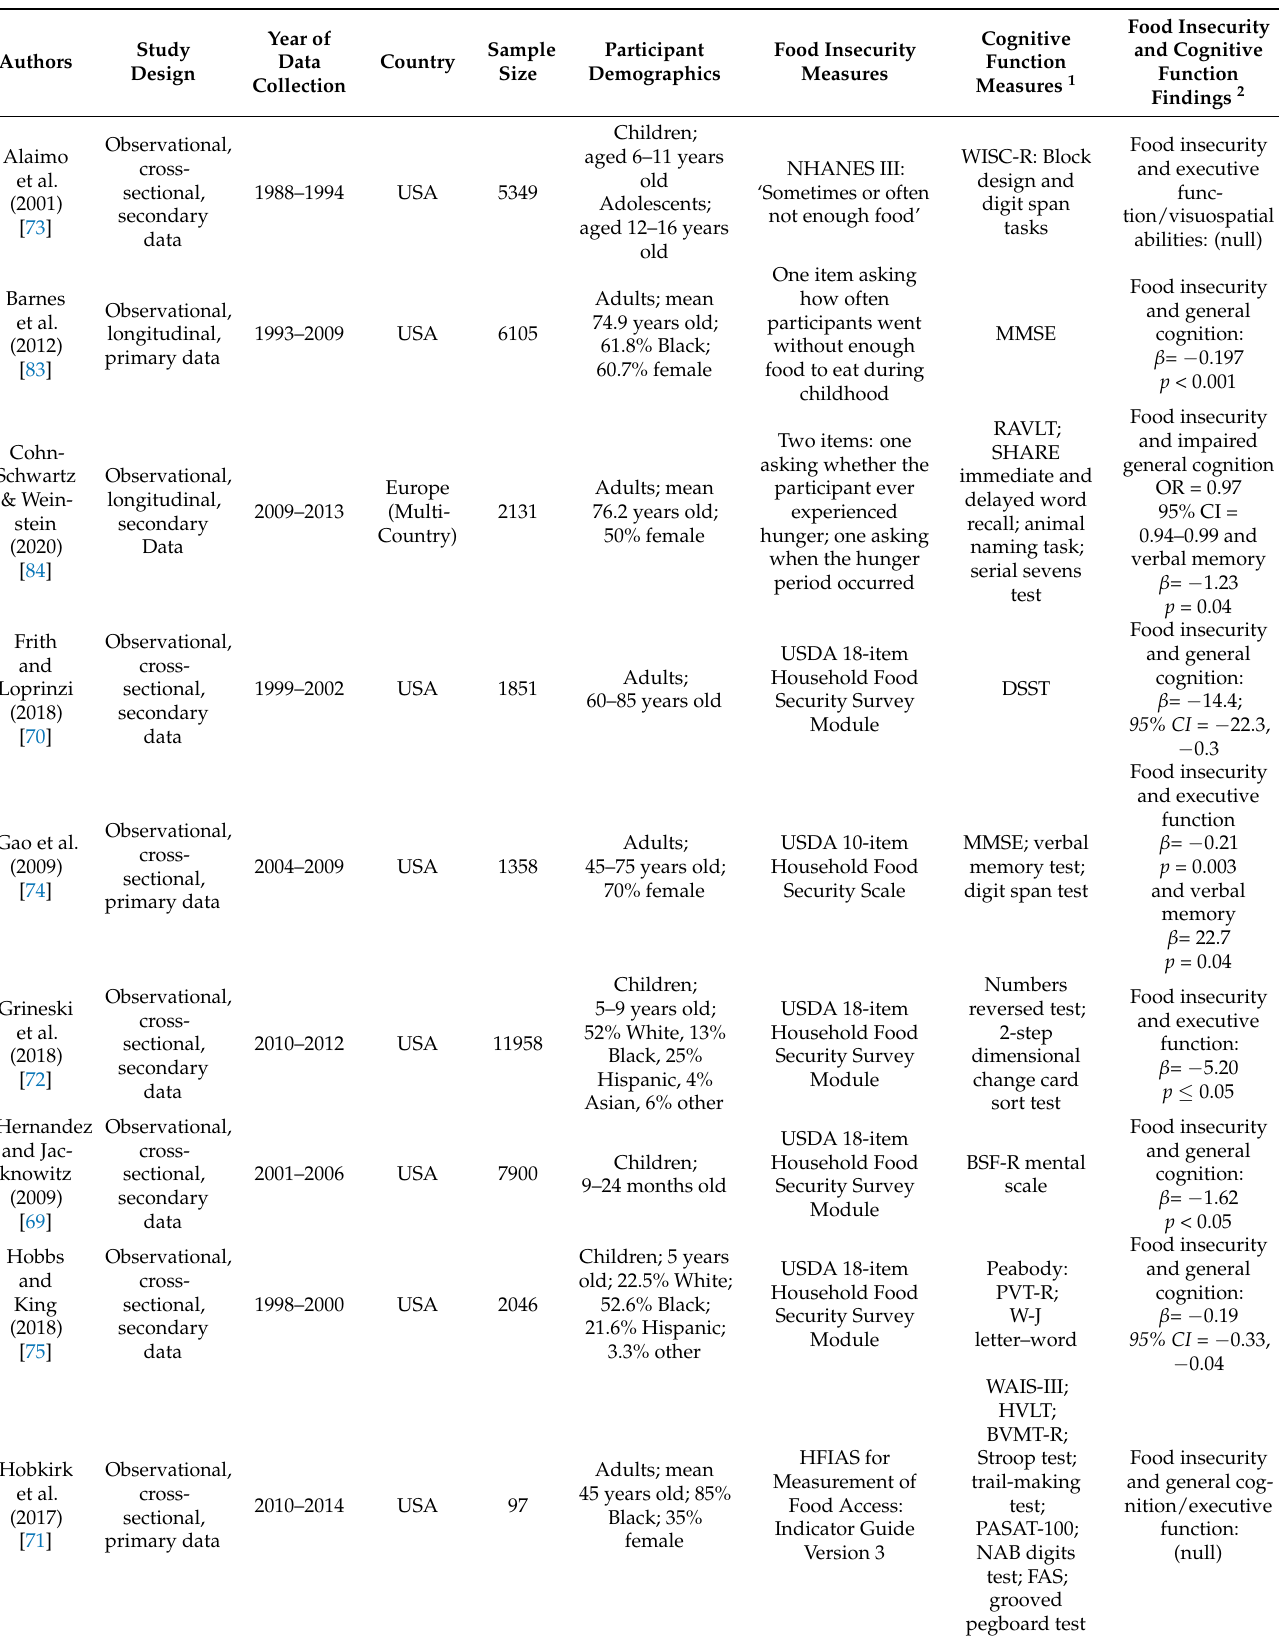
Table 1. Characteristics, measures, and outcomes for studies examining food insecurity and cognitive function ( n =